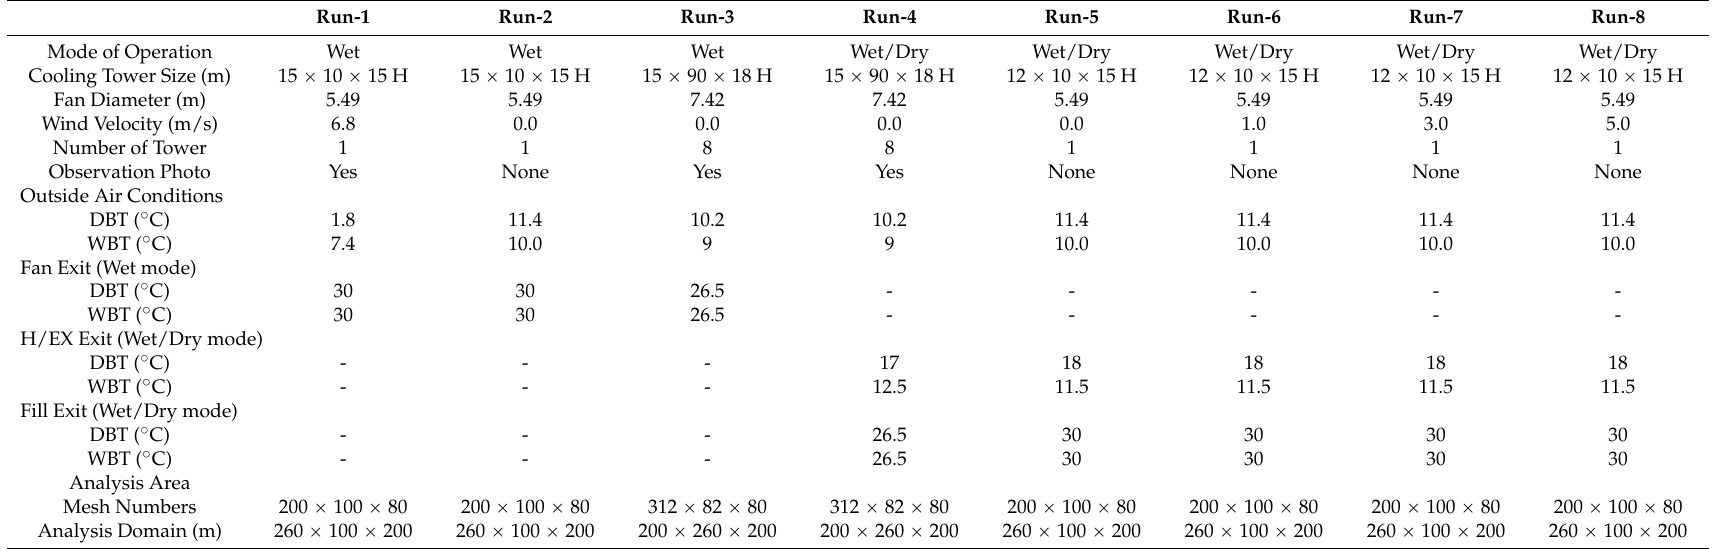
Figure 5. Velocity distributions at the outlet of the exhaust fan measured using model equipment [8].